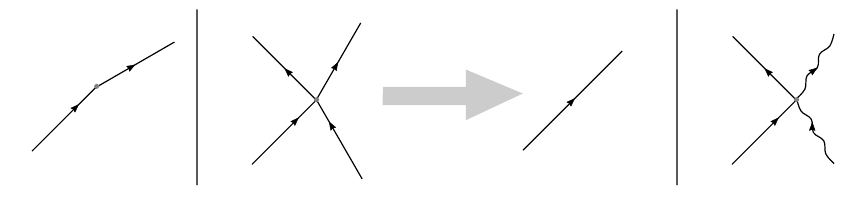
Figure 2: Left panel: The hydrodynamics is driven by two processes. First, is the ballistic propagation of particles with the velocity that depends on the local distri- bution of particles. The second process, that leads to the diffusion, is the scattering between the particles. Right panel: In the linearized regime both processes gets sim- plified. The ballistic propagation occurs now with the space-time constant velocity determined by the particles rapidity and the background state n ( θ ) . The scattering events, driving the diffusion, are now between the perturbation and the background particles and are controlled by the dressed scattering phase shift T dr